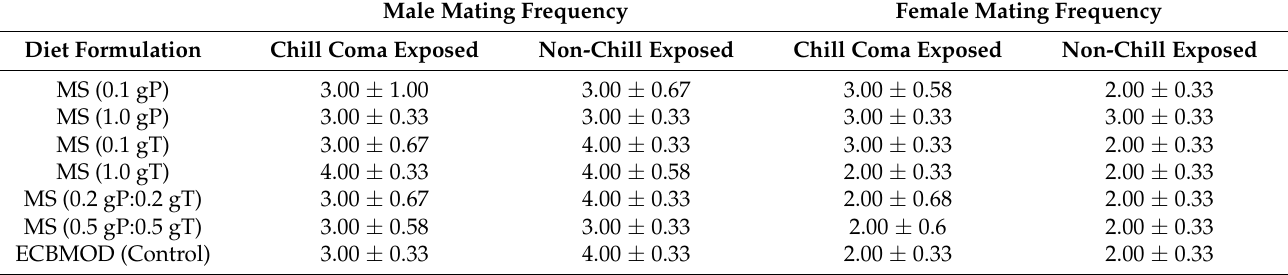
Table 8. Mean ( ± SE) mating frequency of chill coma exposed and non-chill coma exposed Eldana saccharina male and female moths [ n = 15], after being paired with moths from the same formulations but not exposed to chill coma, from the MS (0.1 gP), MS (1.0 gP), MS (0.1 gT), MS (1.0 gT),